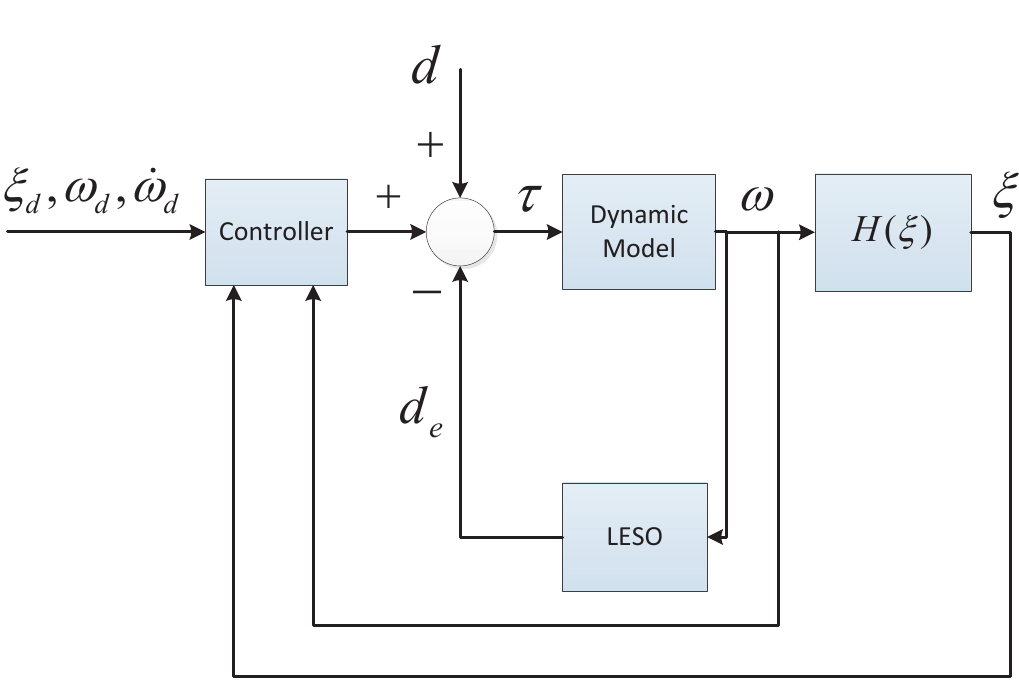
Figure 3. Control scheme. LESO: Linear Extended State